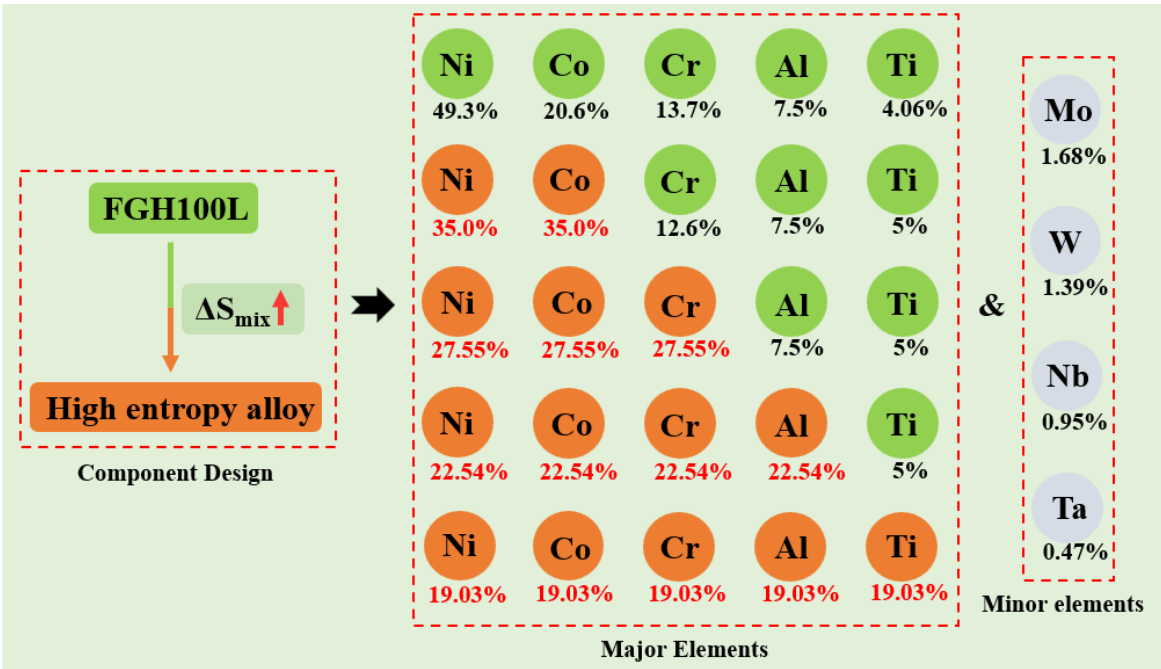
Figure 1. High entropy design based on FGH100L.